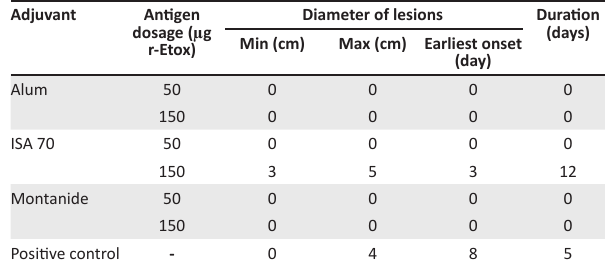
TABLE 4: Safety of enterotoxaemia candidate vaccines in sheep.